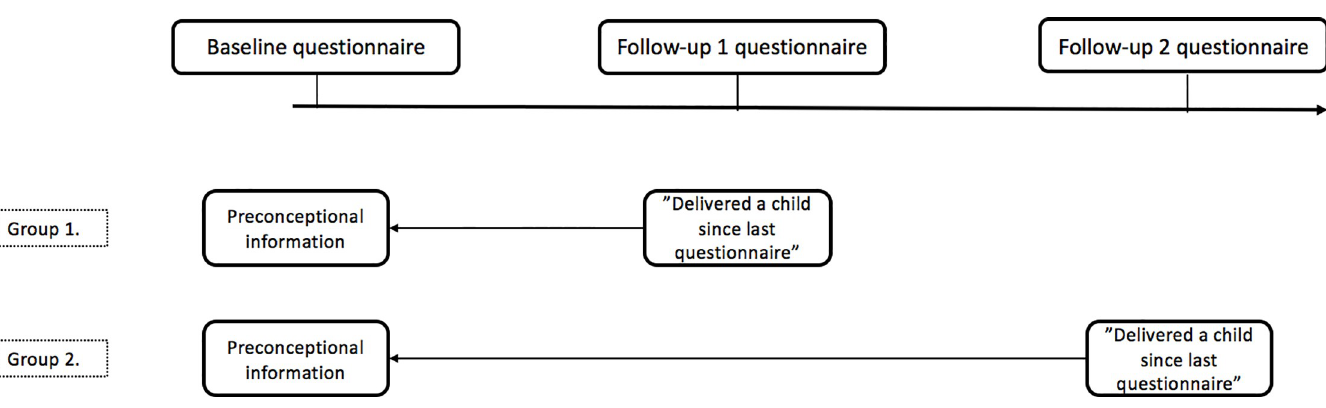
Fig 1. Overview Lifelines